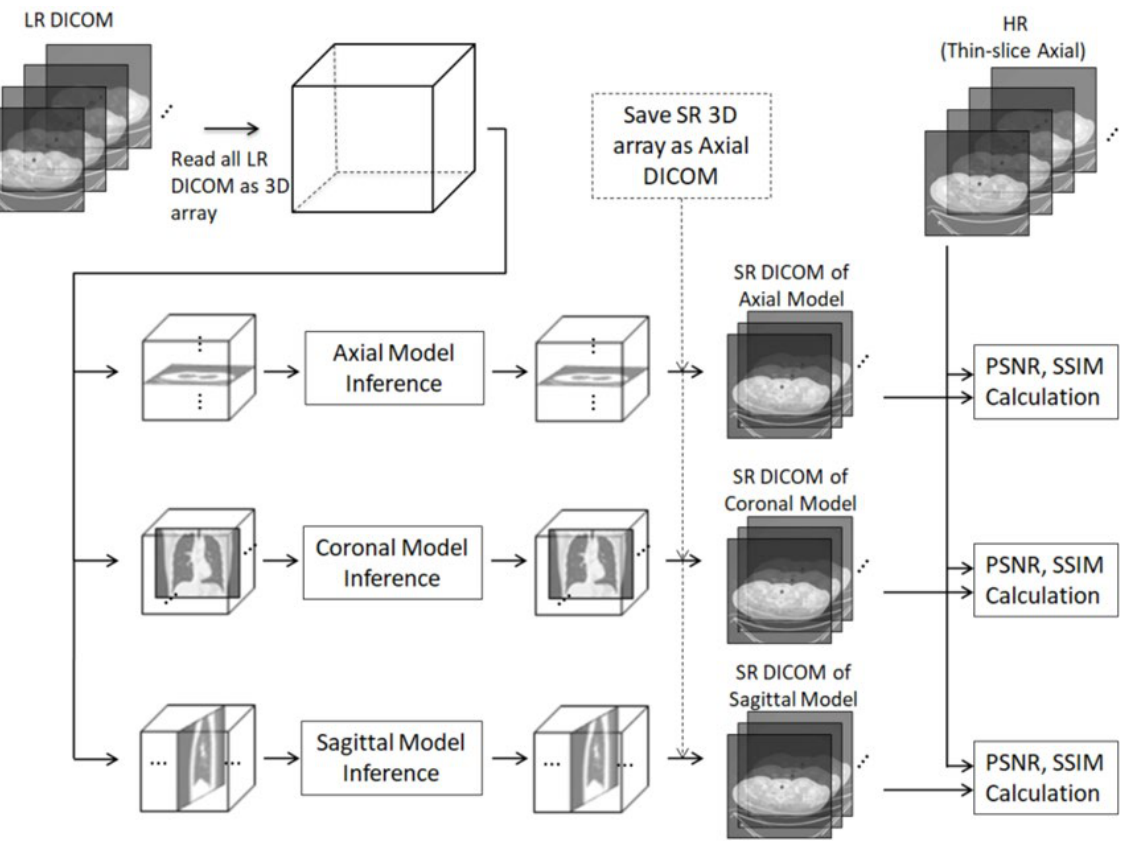
Figure 7. Testing PSNR and SSIM calculations.